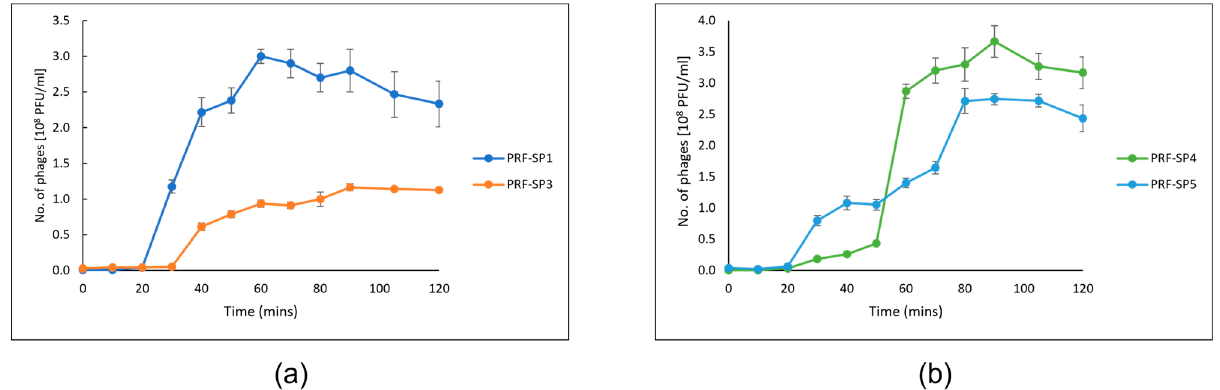
Figure 1. One-step growth curve. ( a ) Growth profile of phage PRF-SP1 and PRF-SP3 against Salmonella Paratyphi A CS/SPA18. ( b ) Growth profile of phage PRF-SP4 and PRF-SP5 against Salmonella Paratyphi B